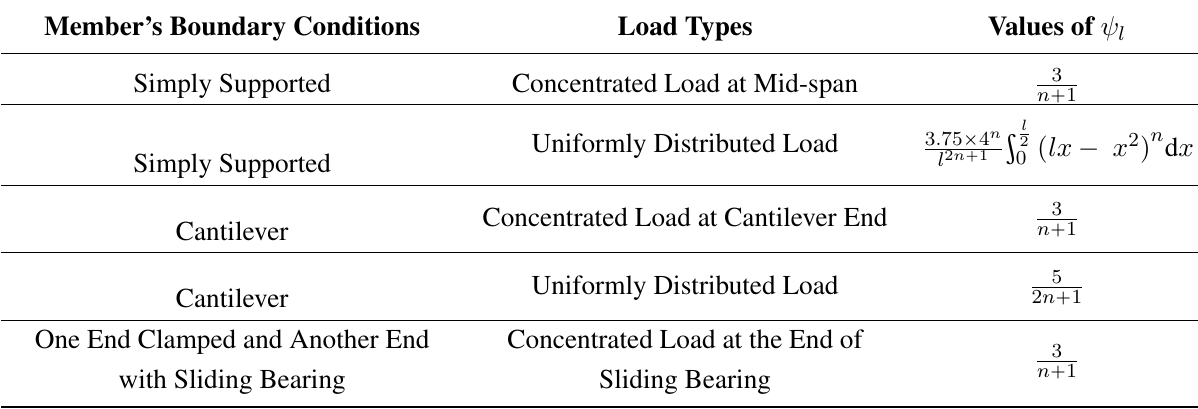
Table 2. Values of ψ for some boundary conditions with special l